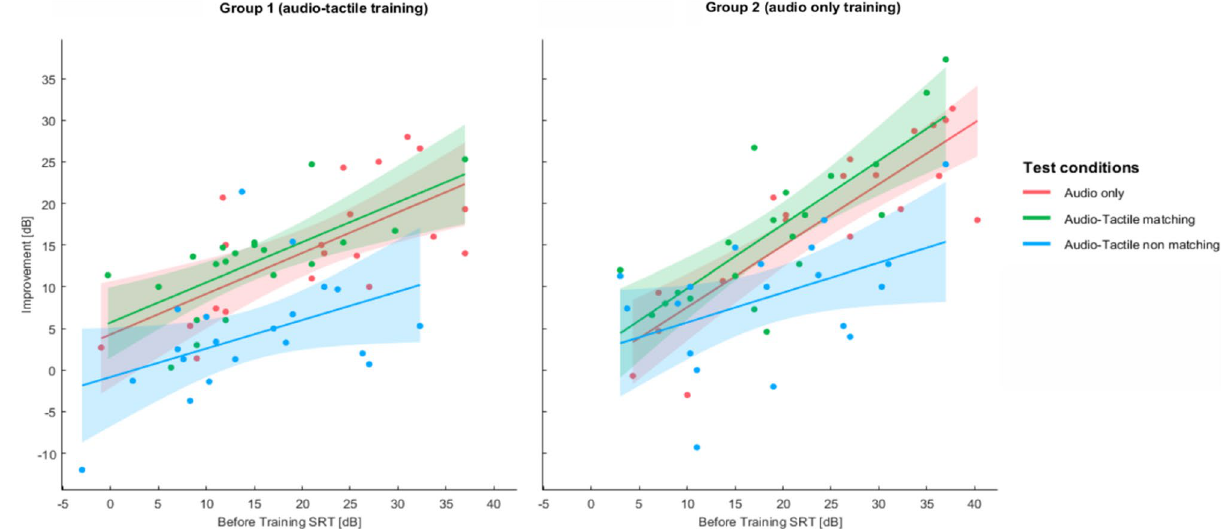
Figure 5. Scatterplots showing a positive relationship between SRT values obtained in three tests before training and the amount of improvement in each of them; shadowing corresponds to a 95% confidence